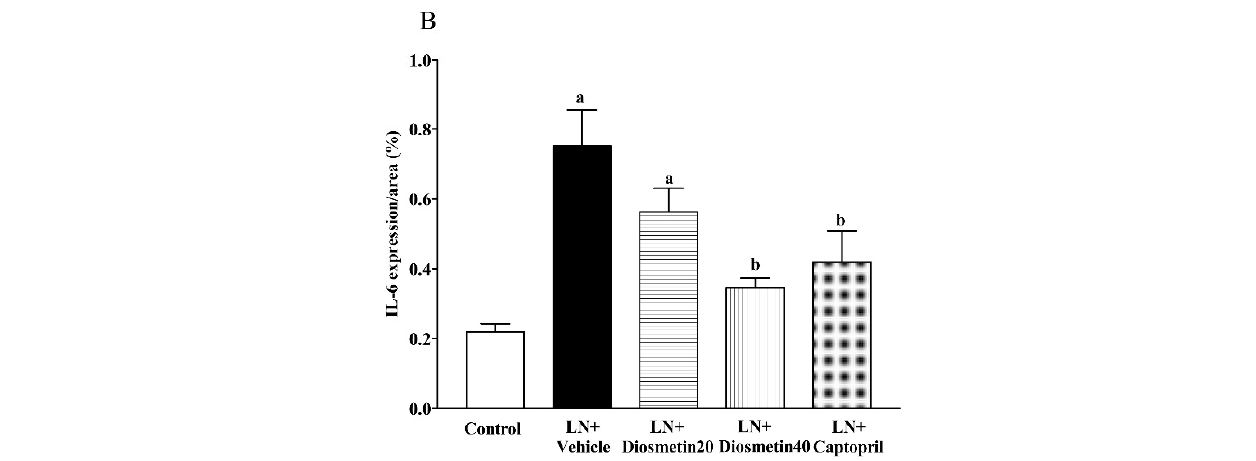
Figure 8. Effect of diosmetin and captopril on interleukin-6 (IL-6) immunohistochemical staining for vascular tissue ( A )